Question: Write a single sentence explaining what this figure depicts.
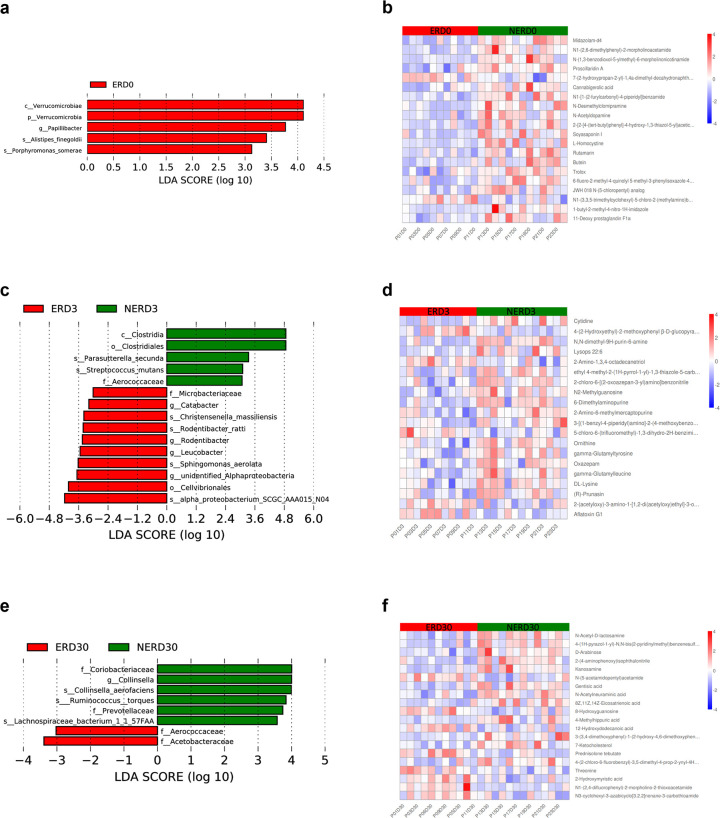
Answer: Differential gut microbiota and metabolites between excellent response (ER) and non-excellent response (NER) group. ( a, c, and e ) Linear discriminant analysis (LDA) effect size analysis (LEfSe) of gut microbiota between ER and NER on Day0 ( a ), Day3 ( c ), and Day30 ( e ); all listed taxa were significantly (Kruskal-Wallis test, P < 0.05, LDA score > 3) enriched for their respective groups. ( b, d, and f ) Heatmap of the top20 differential metabolites between ER and NER on Day0 ( b ), Day3 ( d ), and Day30 ( f ).